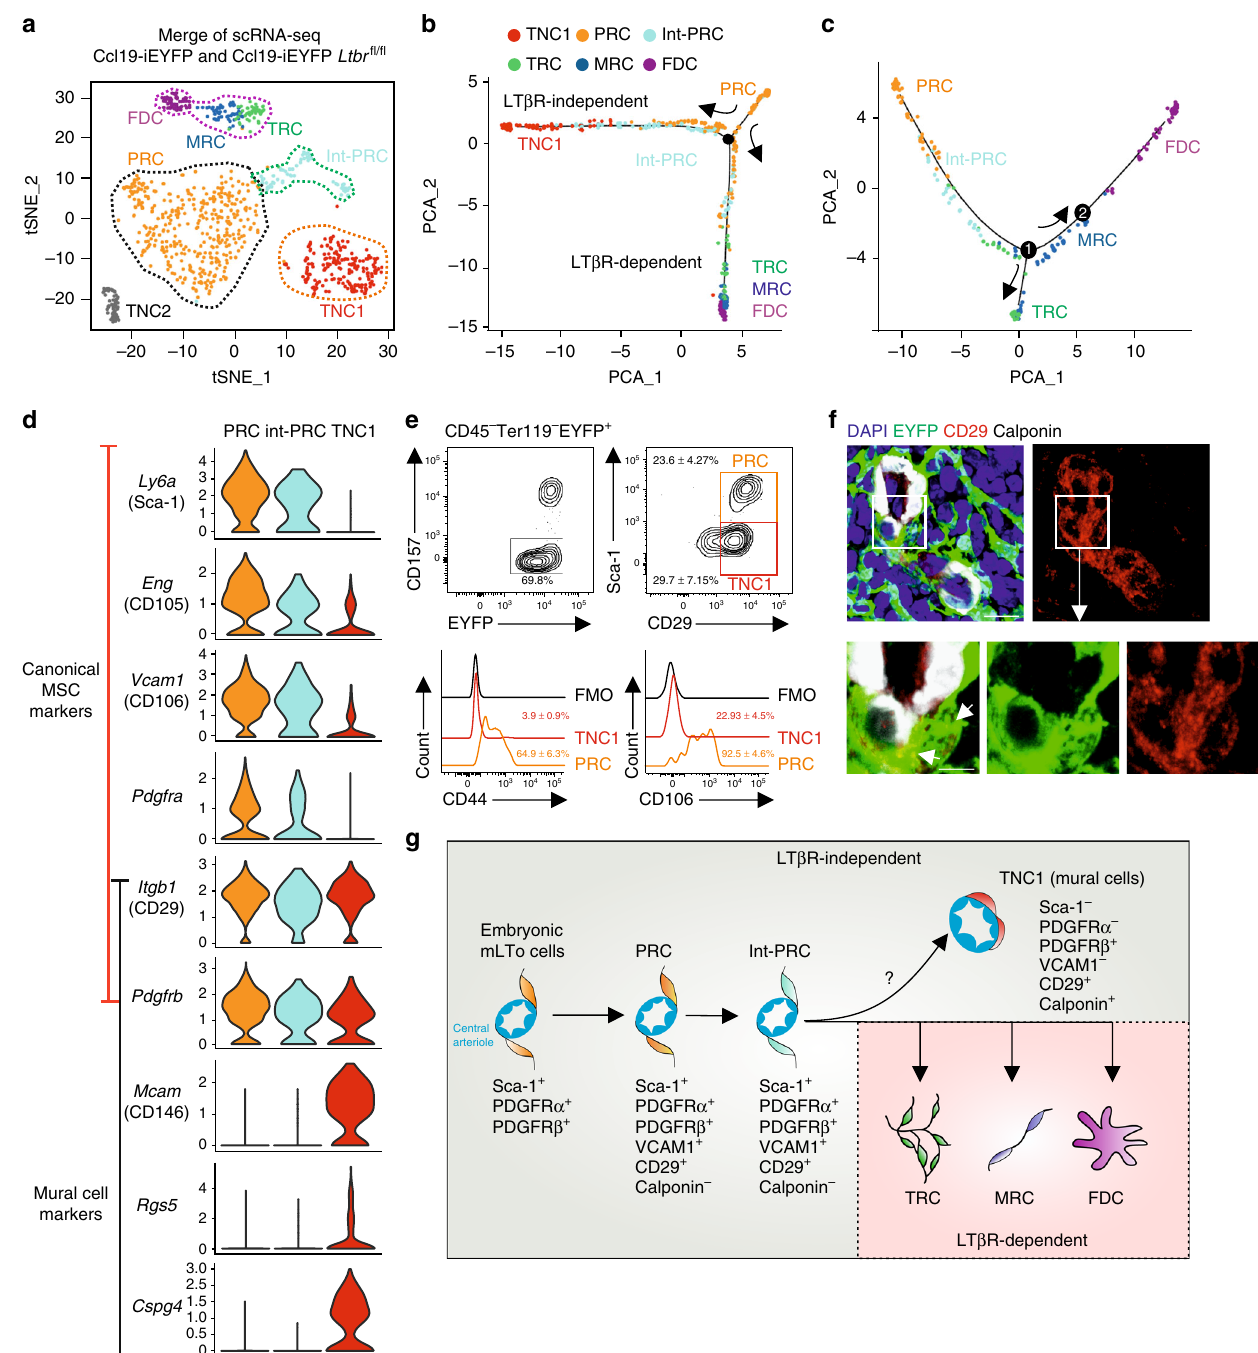
cells, for example, have been suggested to originate from pre- adipocyte progenitors 36 , which are triggered by retinoic acid from adjacent neurons to produce CXCL13 37 . Based on the overlap in the expression of selected markers, MRC have been suggested to represent an intermediate mLTo cell 38 and to give rise to FDC 39 . combined with heterotopic transfer of stromal cell populations has led to the conclusion that adventitial progenitors from SLOs can give rise to one 40 or several reticular cell subsets 41 . Moreover,